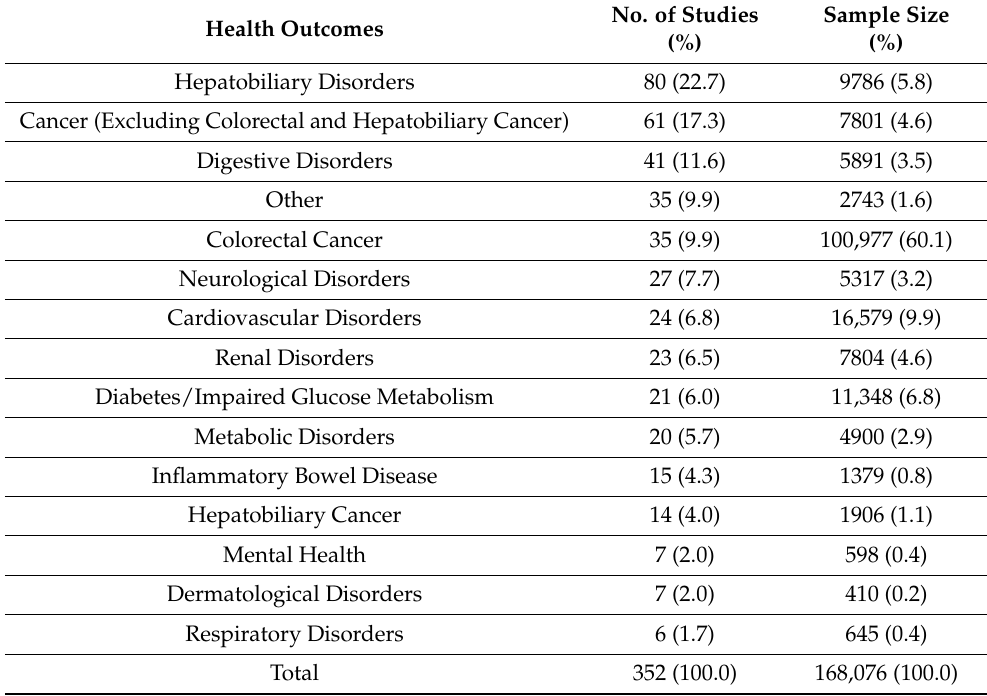
Table 2. Distribution of Health